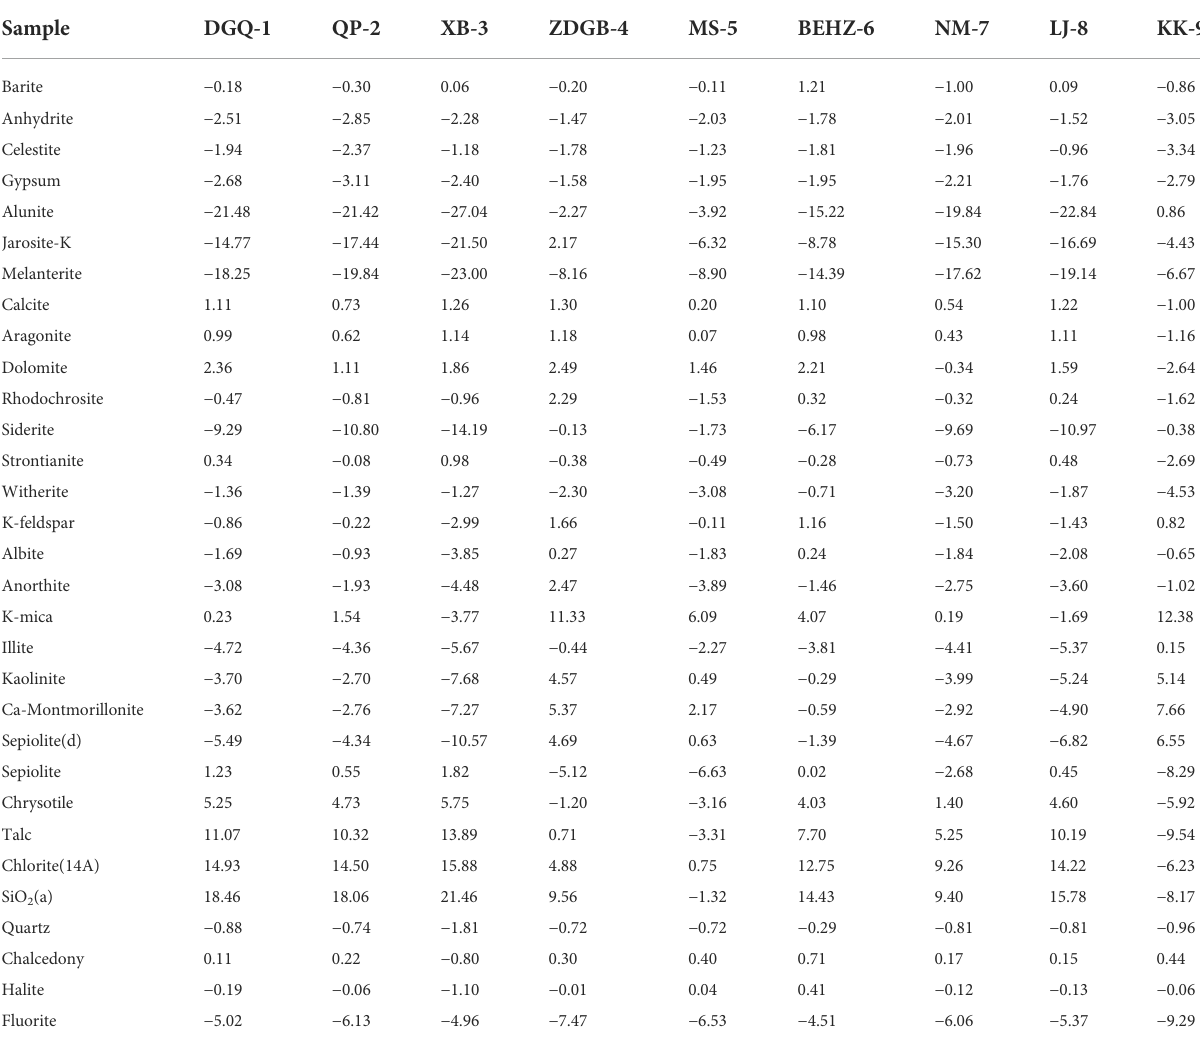
TABLE 3 SI values of minerals in the spring waters along the Karakorum